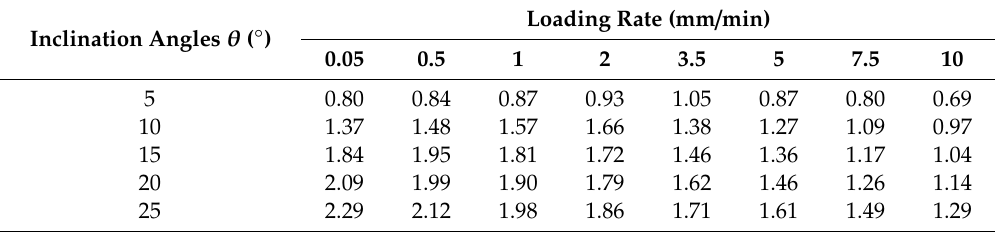
Figure 8. Variation law of peak shear stress with loading rate and inclination angle: ( a ) Relationship between peak shear stress and inclination angle; ( b ) relationship between peak shear stress and loading rate. Table 1. Peak shear stress values of coal samples under different loading rates and inclination angles (MPa).